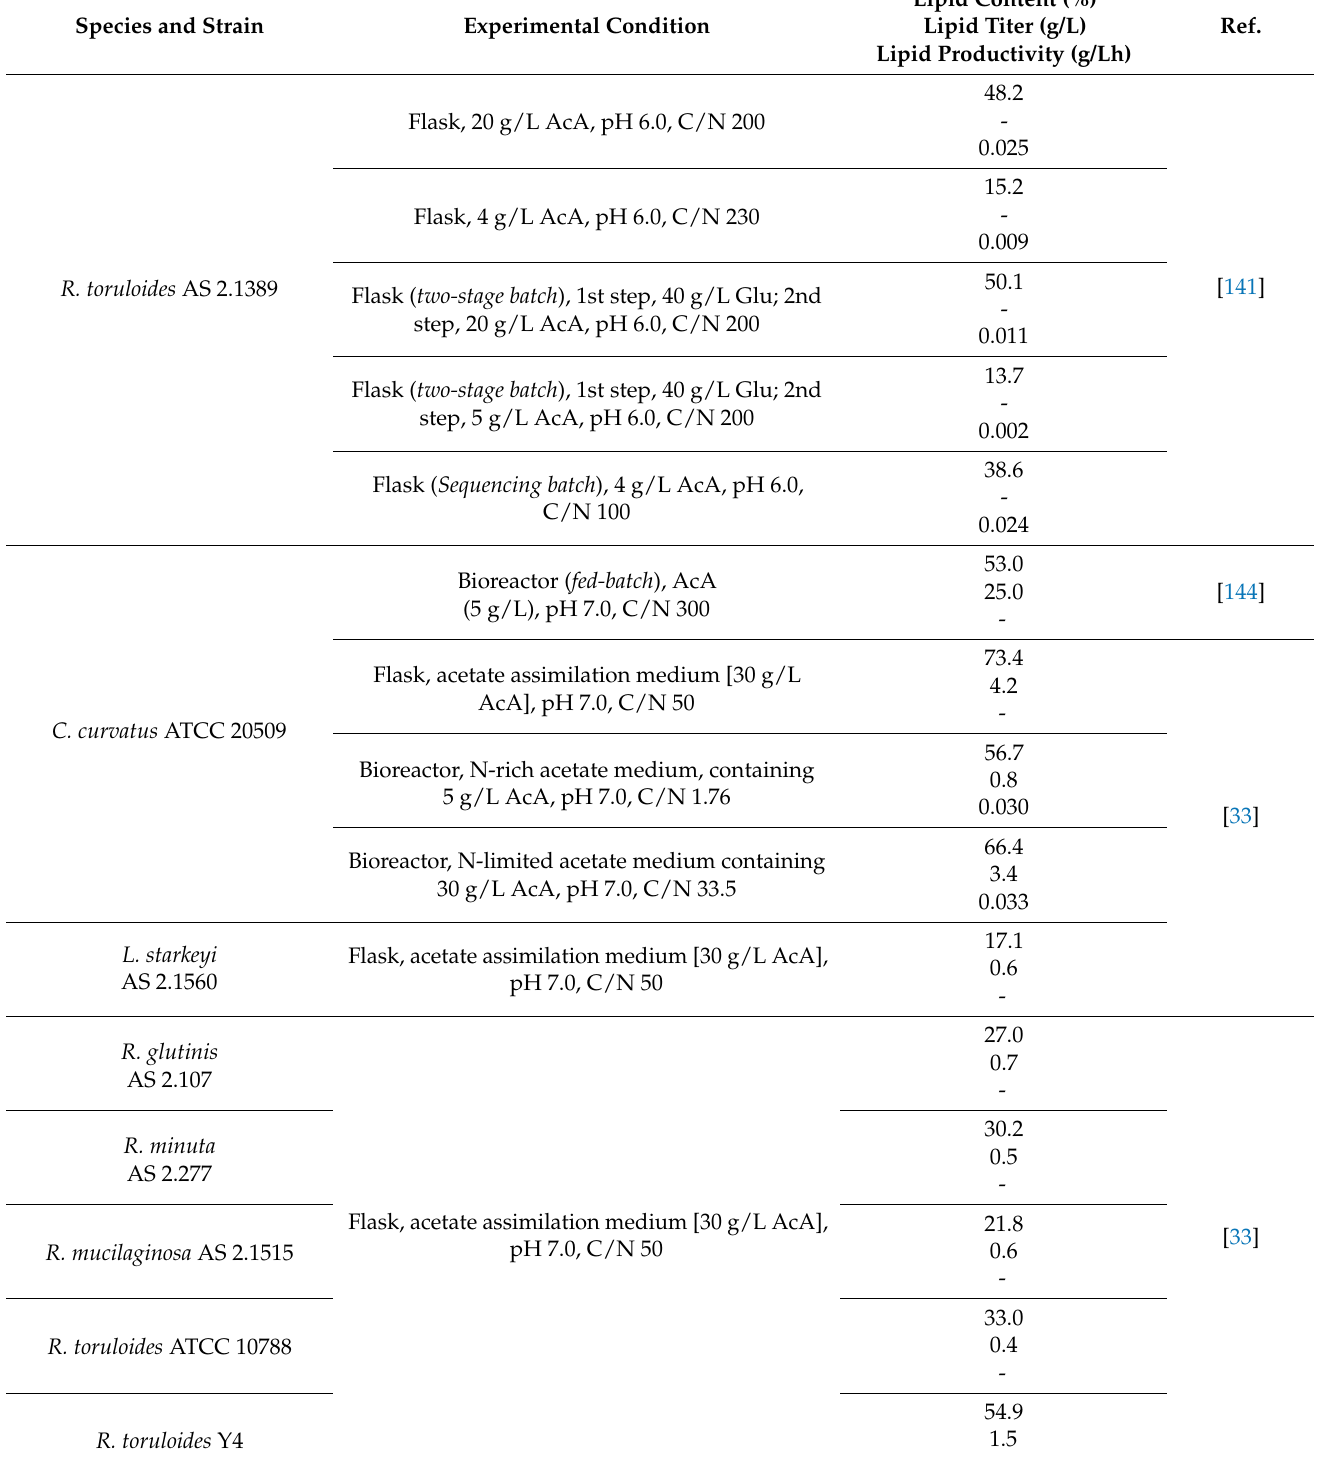
Table 3. Lipid production by oleaginous yeasts ( Cryptococcus curvatus , Rhodotorula toruloides , Lipomyces starkeyi , Rhodotorula glutinis , Rhodotorula minuta , Rhodotorula mucilaginosa , Trichosporon cutaneum , Trichosporon fermentans and Yarrowia lipolytica ) using acetic acid as carbon source. The experimental conditions column also contains information on the culture method used: flasks, two-stage batch, sequential batch, fed-batch and semicontinuous